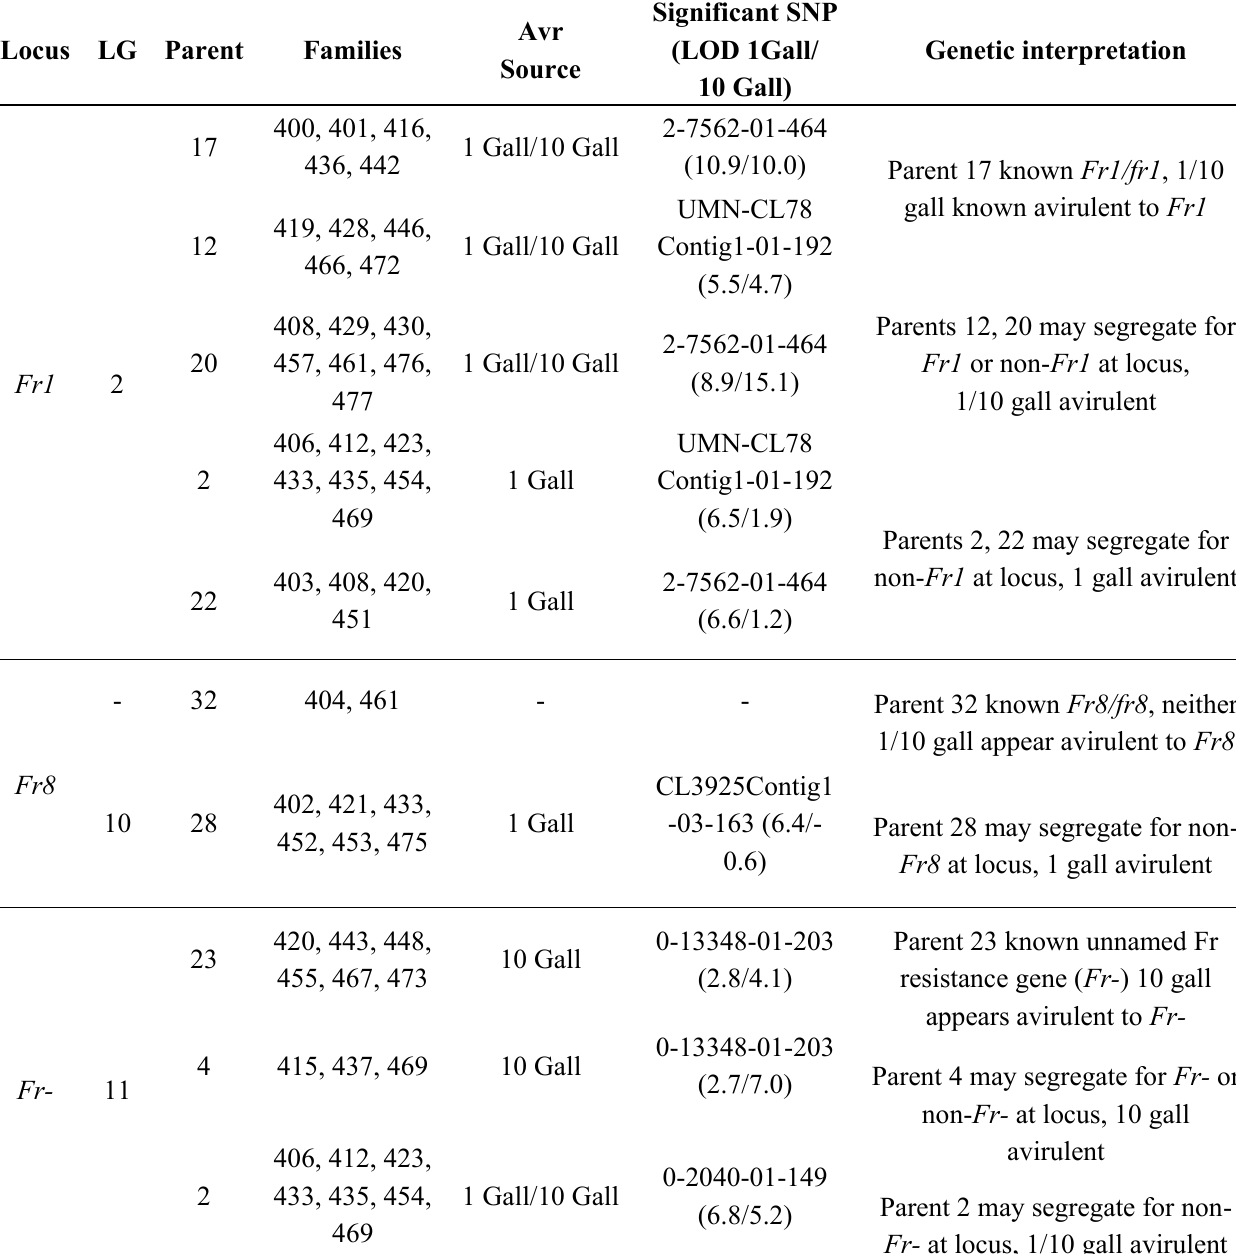
Table 2. Significant SNPs obtained using BayesC  and BAMD that mapped to linkage groups (LG) containing Fr genes. Each parent was known from previous work to segregate for a major gene, or yielded a LOD score >4 when the genotypic classes for the SNP were regressed on gall score breeding values from one gall and 10 gall inoculation